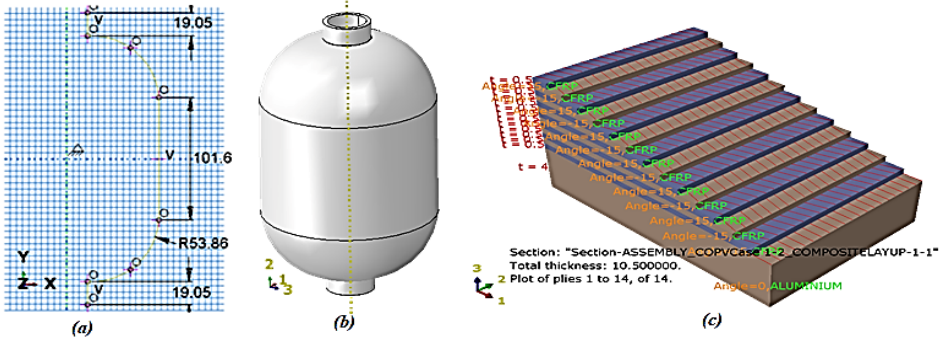
Figure 4. COPV: ( a ) Dimensions’ layout, ( b ) 3D model of the linear, and ( c ) Stack sequence of